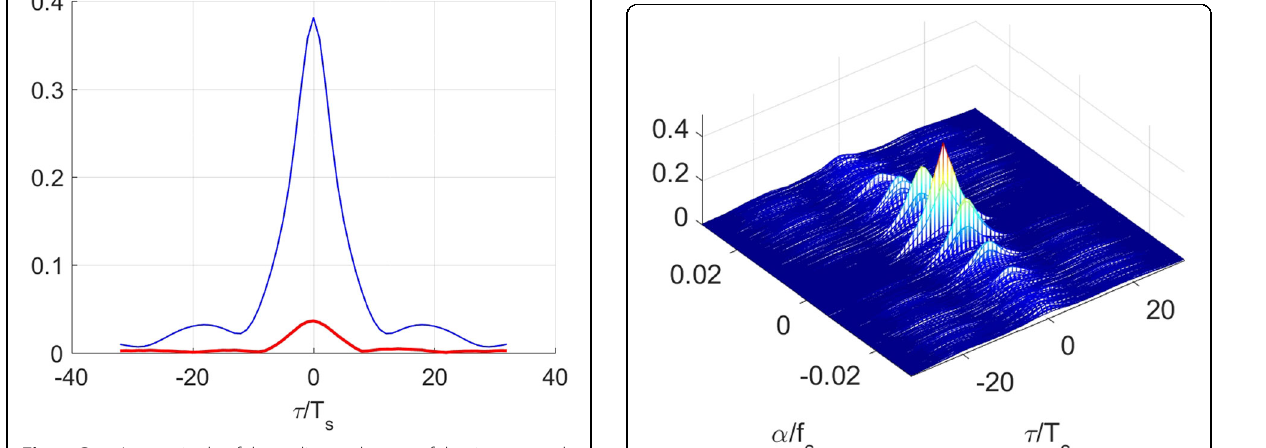
Fig. 5 Case A: magnitude of the cyclic correlogram of the time-warped data (thick red line) and of the data before warping (thin blue line) as functions of lag τ / T s at cycle frequency α ¼ 1 = T o ( SNR ¼ 10 db)